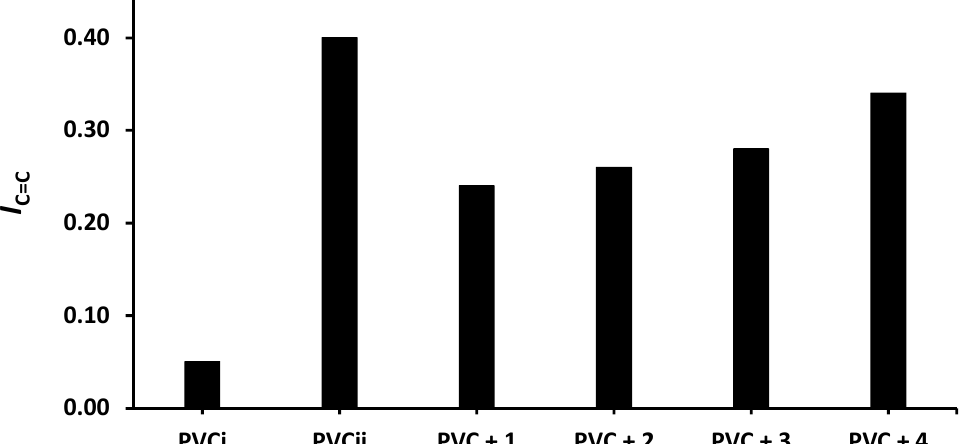
Figure 6. Effect of irradiation (300 h) on the index of the C=C group ( I C=C ) of PVC films containing tin(IV) compounds 1 – 4 . PVC i and PVC ii are the I OH of the blank PVC film before and after irradiation, respectively.